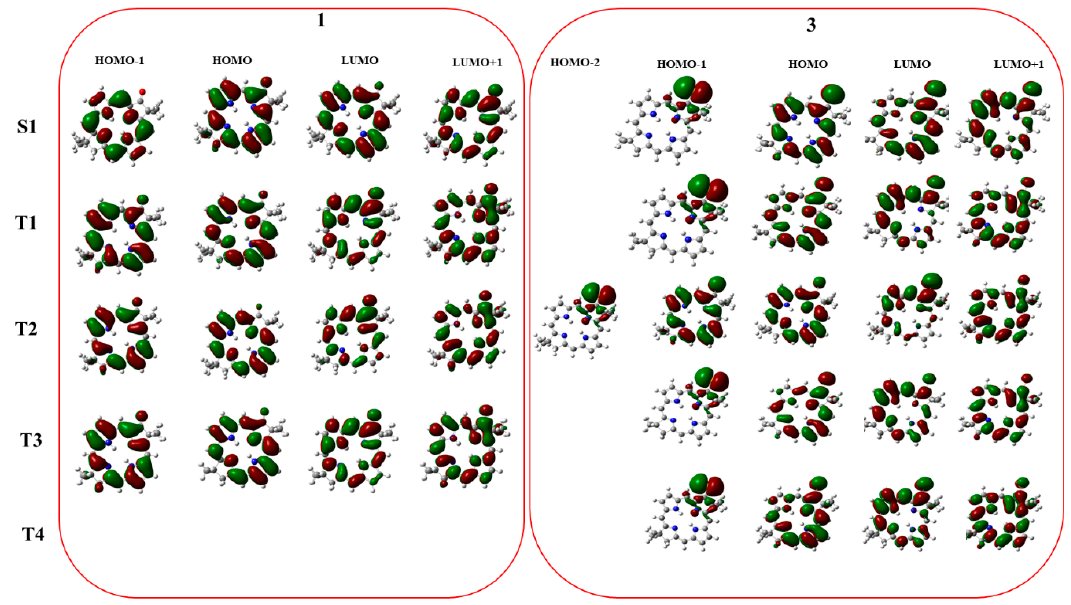
Figure 1. Molecular orbital composition for the excited states involved in the singlet and triplet excitation for molecules for 1 and 3 molecules.